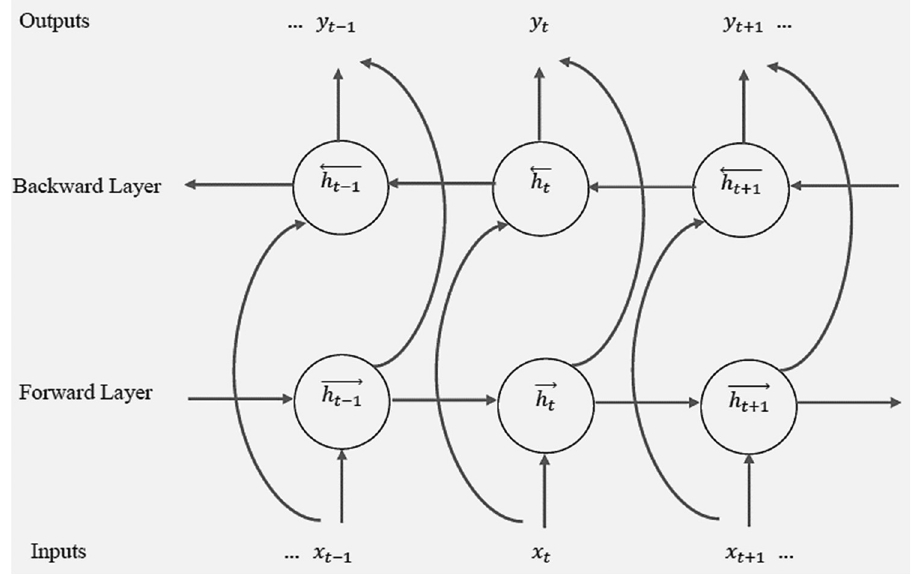
Figure 7: The BiLSTM architecture [ 23 ] .